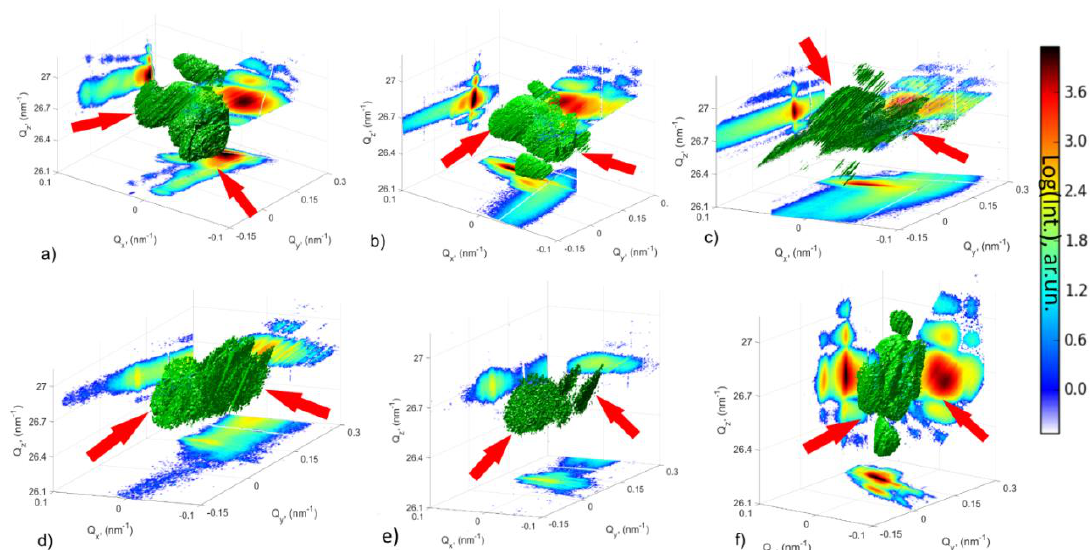
Figure 2. Three-dimensional iso-surfaces of diffraction intensity at different loading stages during the in situ three-point bending test recorded using energy scans: ( a ) pristine nanowire, ( b – e ) under increasing load, ( f ) unloaded nanowire. The arrows highlight the two parts of the Bragg peak that separate from each other during loading of the nanowire.